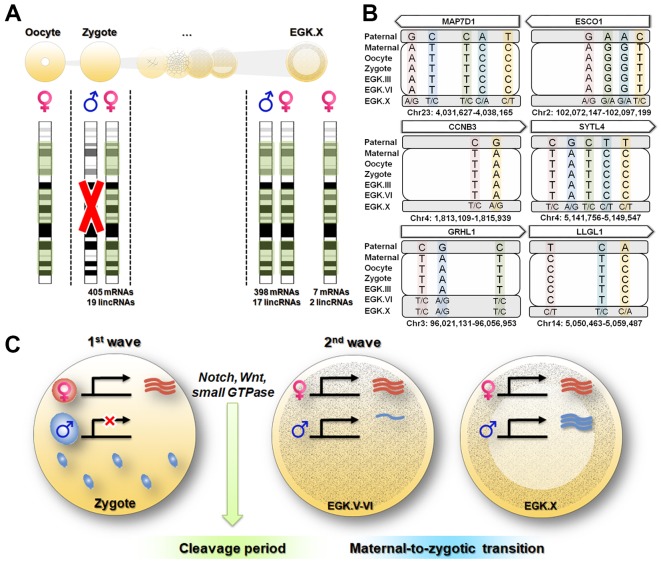
Maternal genome activation (MGA) during the 1st wave of transcriptional activation in chicken zygote.(A) Determination of parental allelic expression from the zygote stage. Only maternal alleles were observed in transcripts induced by stst activation. These maternally derived upregulated genes showed bi-allelic expression after EGK.X. (B) Validation of 1st wave transcription-induced maternal allelic expression by Sanger sequencing. The maternal transcription profile after the 1st wave changed to bi-allelic expression between EGK.VI and EGK.X after the 2nd activation. (C) Schematic summary of genome activation during chicken early development. Only MGA occurred after fertilisation and this wave of gene activation may regulate the cleavage period.